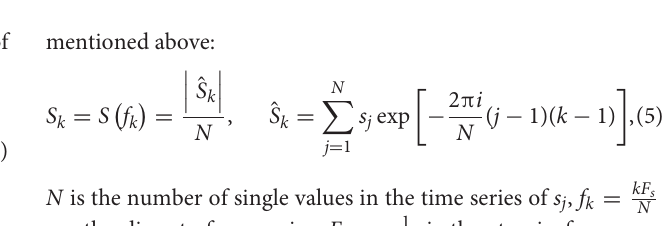
FIGURE 5 | Temporal course of the location of the main pycnocline (A) , near-bottom speed (B) and wavenumber spectra of fluctuations of the vertical location of the main pycnocline (C) at 18.25 ◦ E, 58.56 ◦ N (point BY31 in Figure 3 ). Thin lines in (A,B) panels show the course each 6h. Bold lines represent moving average over 1